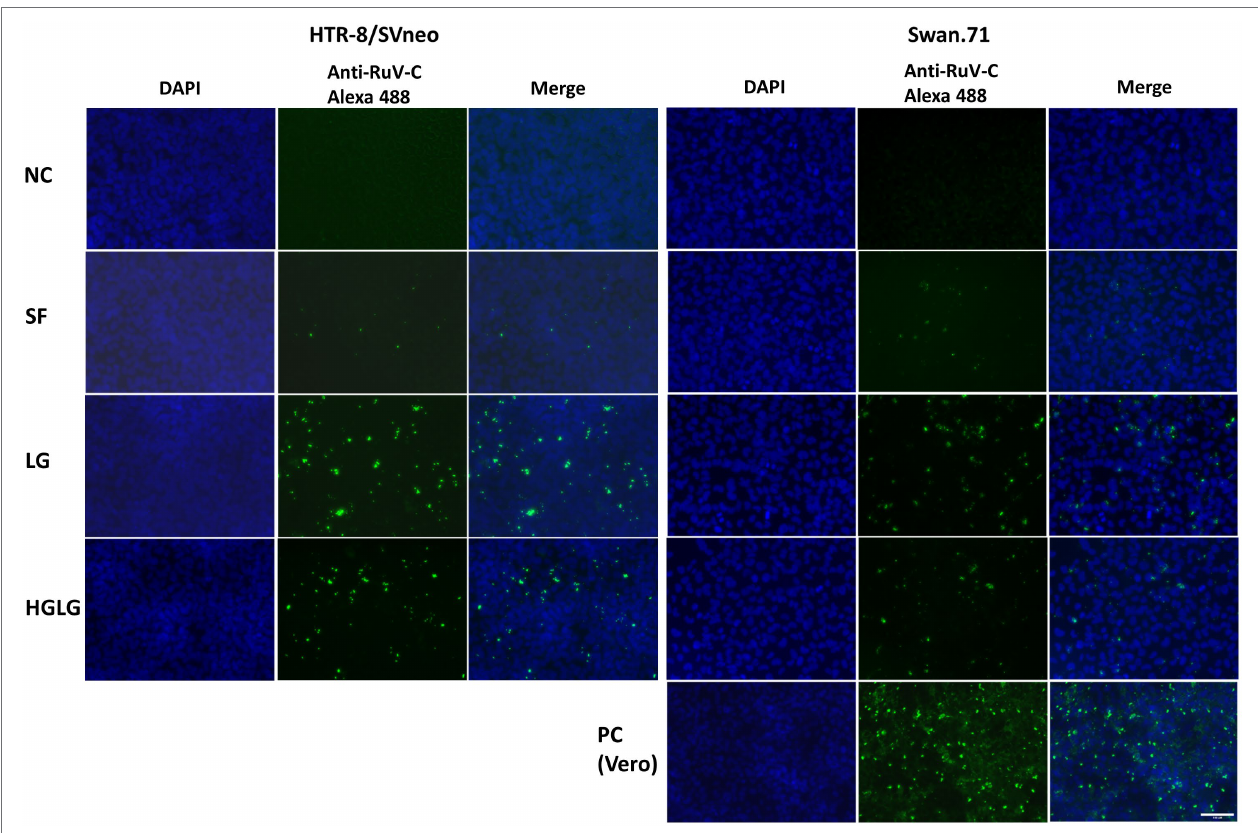
FIGURE 2 | Microscopy images of HTR-8/SVneo and Swan.71 cells infected with RuV under LG stress conditions. The cells were seeded onto 6-well plates containing glass coverslips and cultured for 1 to 2 days before LG stress treatments and viral infection. The cells were fixed 48 hpi and labeled with a mouse monoclonal anti-rubella viral capsid antibody (ab34749, Abcam), followed by an Alexa 488-conjugated goat anti-mouse IgG (H + L) secondary antibody (green). Nuclei were stained with DAPI (blue). RuV-infected Vero cells were used as positive controls. Trophoblast cells mock-infected, incubated with heat-inactivated RuV, or stained with mouse serum were used as negative controls. Images are representative of 3 independent experiments. RuV-C, rubella virus capsid. Scale bar: 100 μ